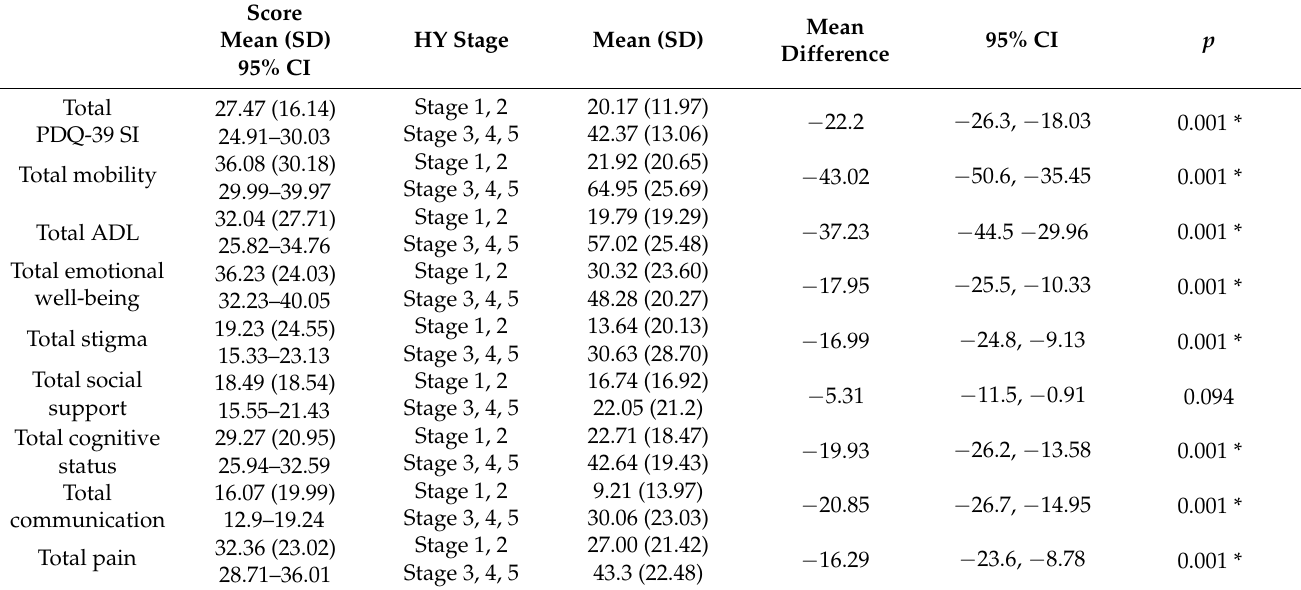
Table 2. Differences between the total scores of the PDQ-39 domains based on the recoded HY stages.